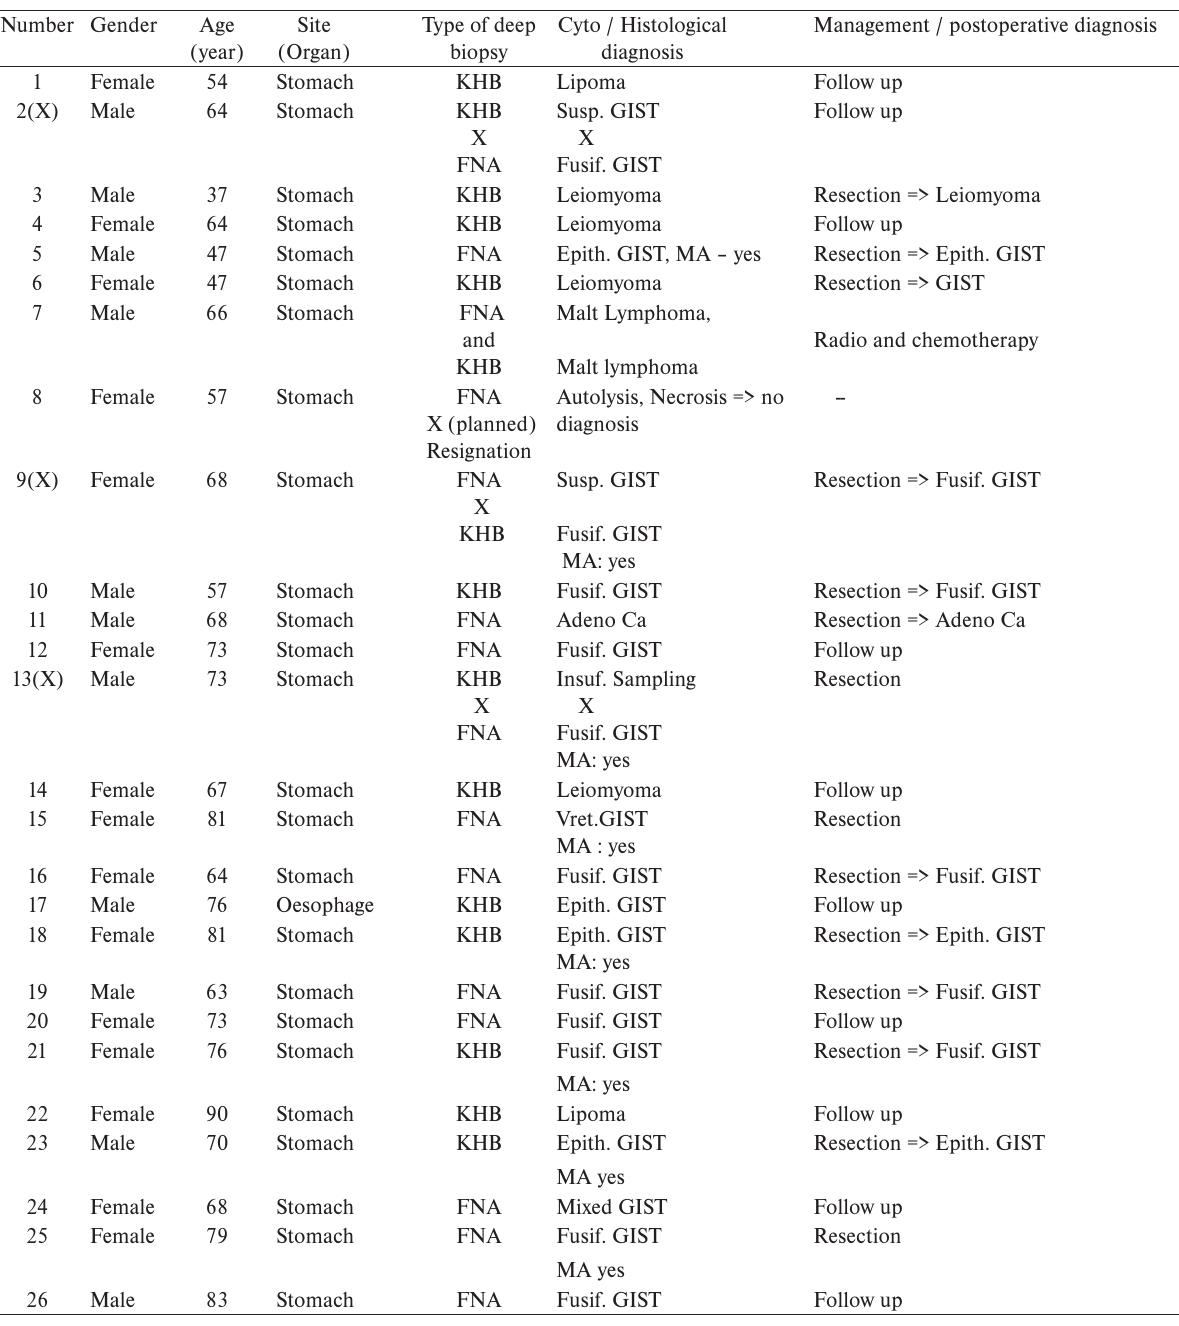
Table 2. Baseline Characteristics of the